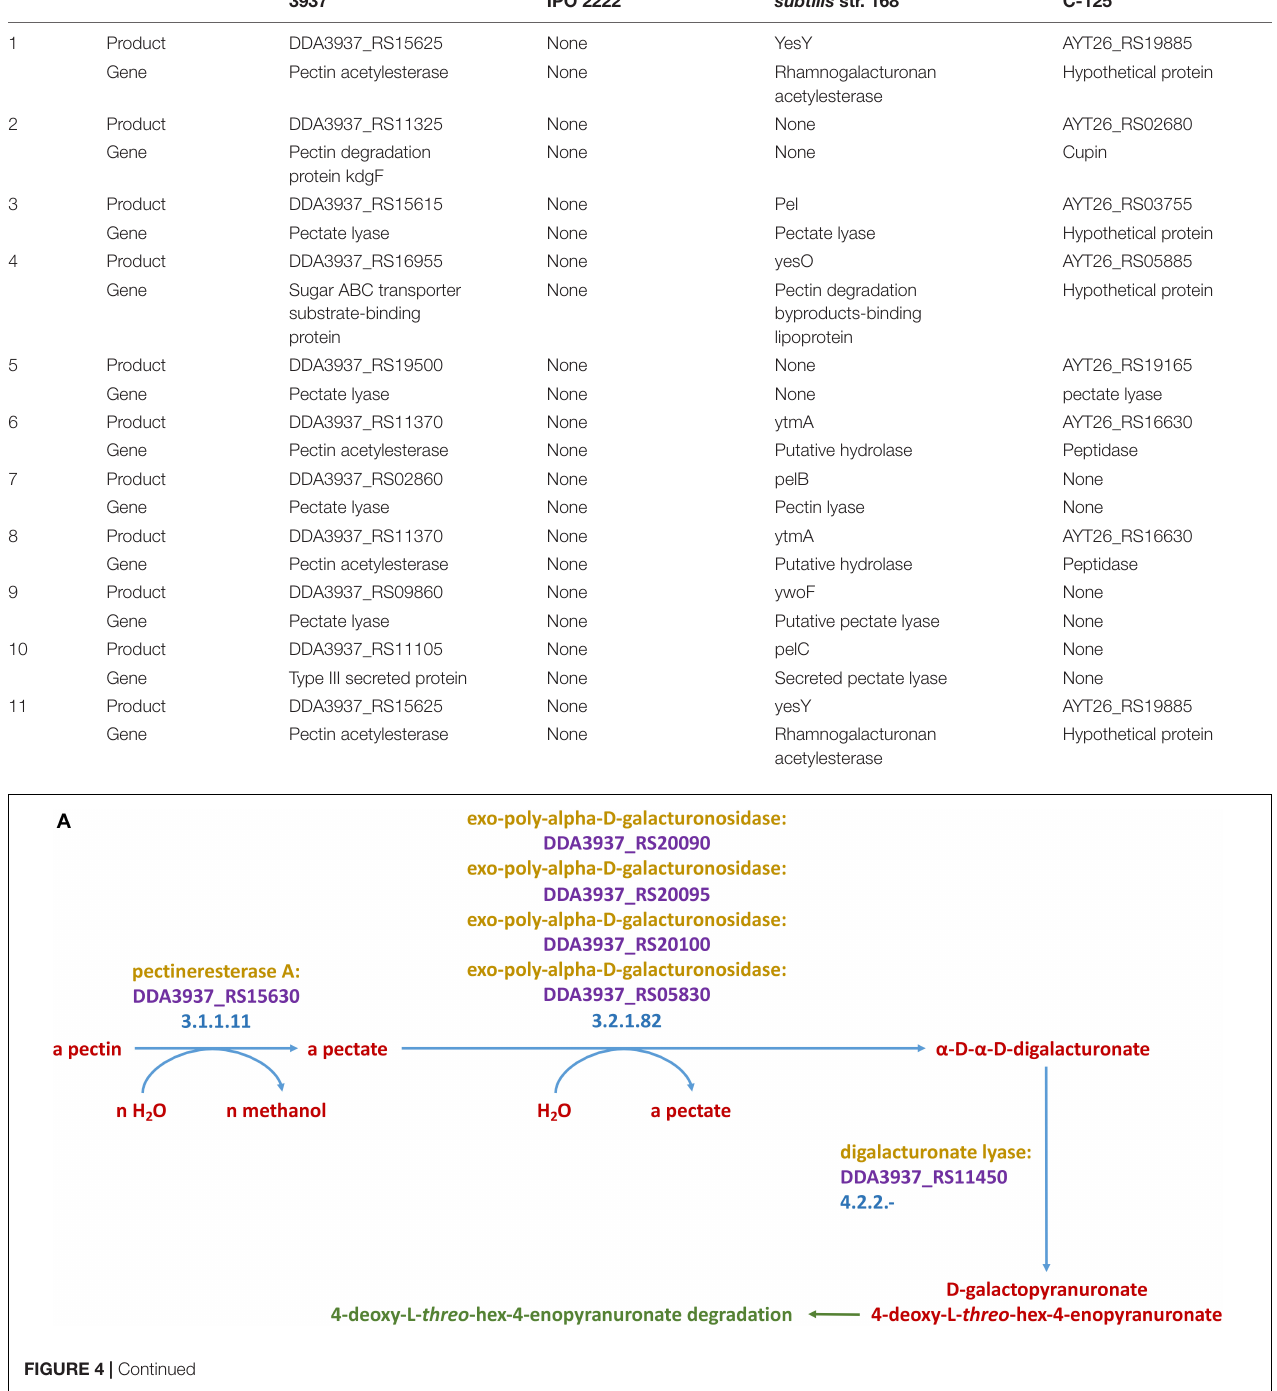
TABLE 5 | Comparison of key pectinase enzymes between four pectinase producing bacteria. Protein